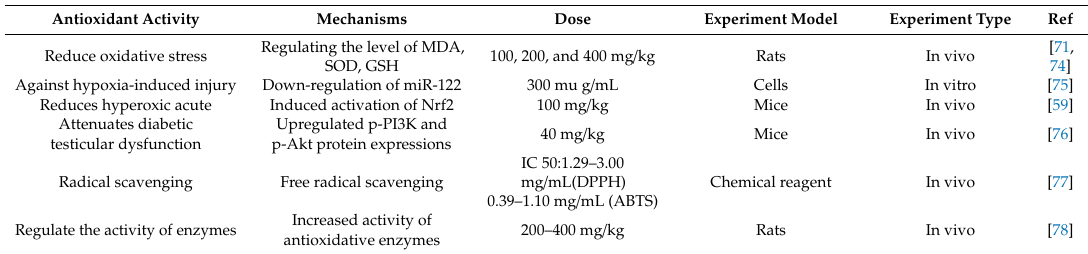
Table 3. Antioxidant activity and mechanisms of